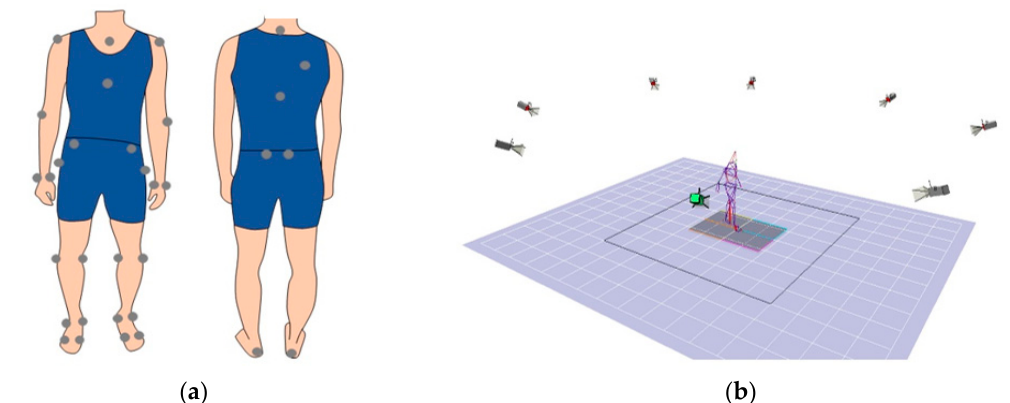
Figure 1. Reflective markers ( n = 33) were attached to 12 segments and a three-dimensional motion analysis system. ( a ) The markers attached to 12 segments. ( b ) A 7 m gait was measured using an 8 camera motion analysis system and 4 force plates.